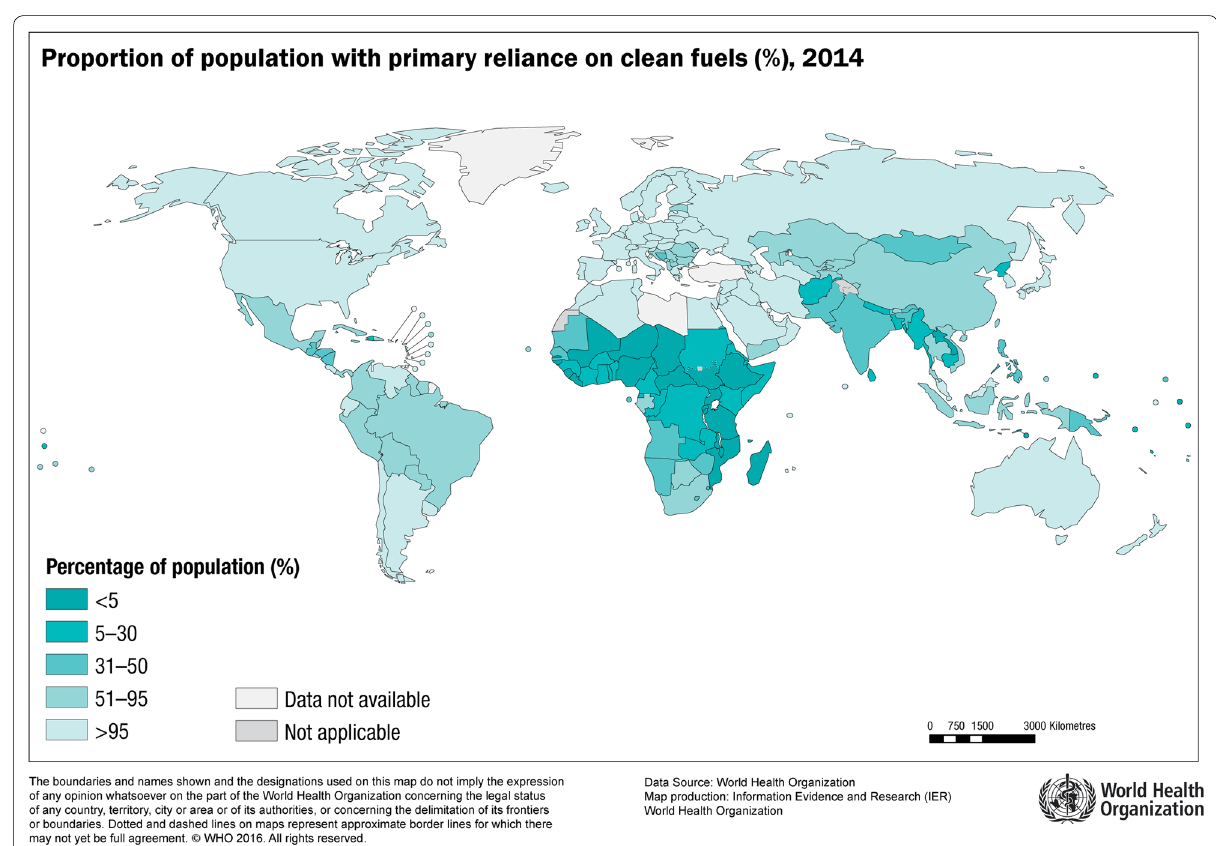
Fig. 1 Global use of clean fuels in 2014, by the World Health Organization. Countries with the lowest (< 5%) and the highest (> 95%) proportion of people using clean fuels as the primary domestic source of energy are shaded dark and light blue, respectively. Reproduced with permission from the World Health Organization [8], Copyright